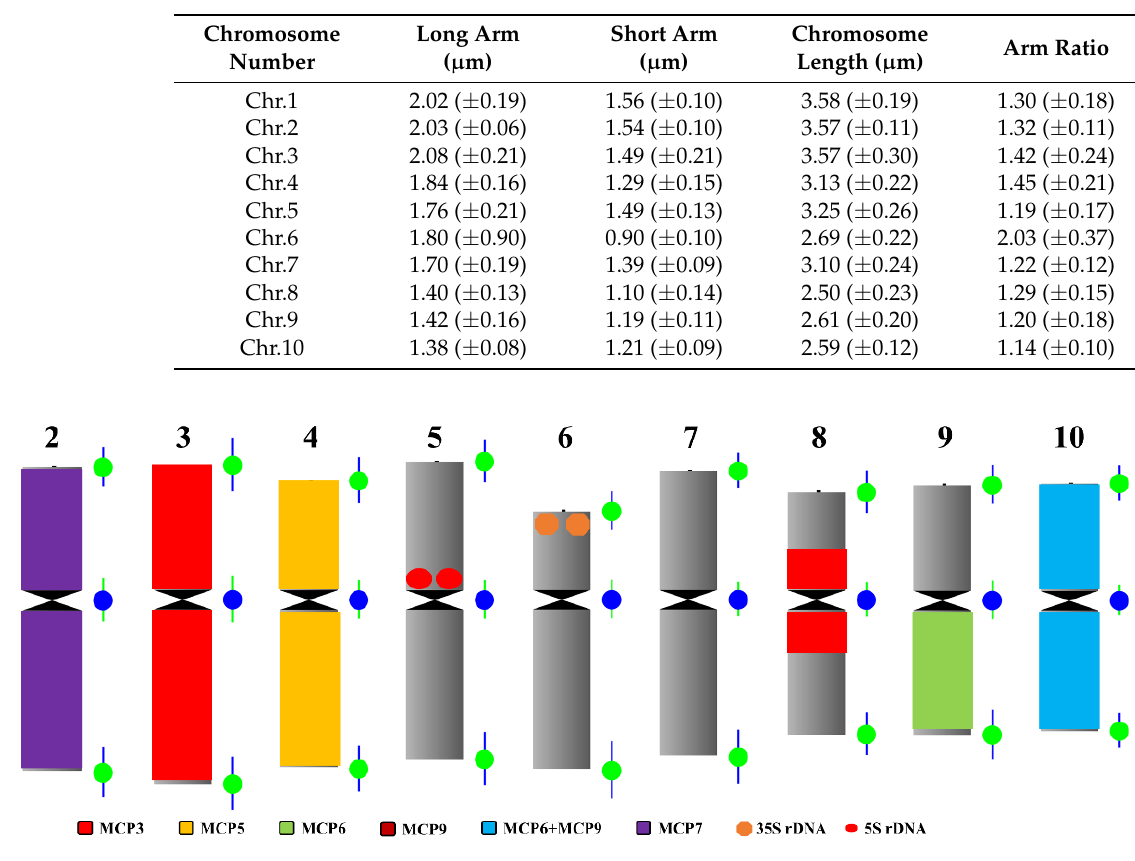
Figure 5. Idiogram of the karyotype in T. arundinaceum. The different colors denote the different probes or combined probes.